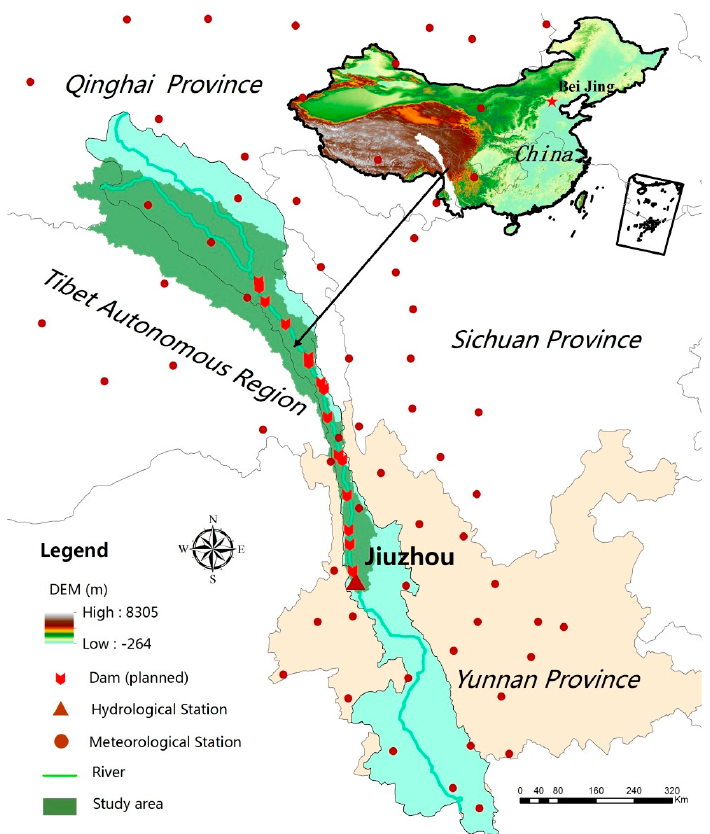
Figure 1. Location of the Jiuzhou Station and proposed dams in the upstream part of the Lancang-Mekong